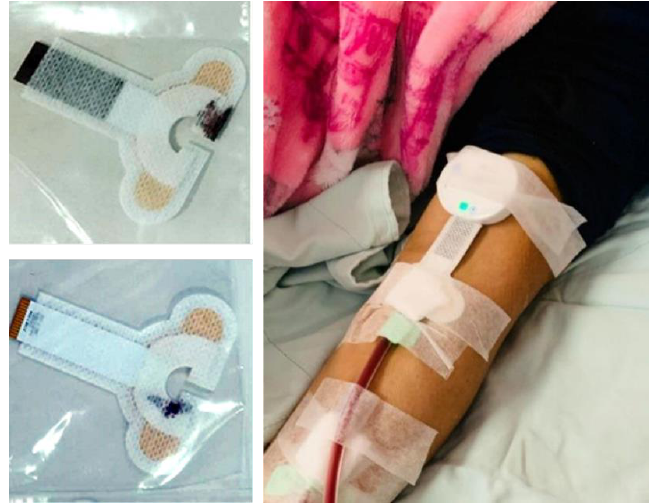
Figure 9. An example of the micro-leakage chart in the clinical trial. A tiny amount of blood infiltrated into a small area emphasized in a direction. The multi-ring design is better than a multiple point-type design for the estimation of leaked blood volume.